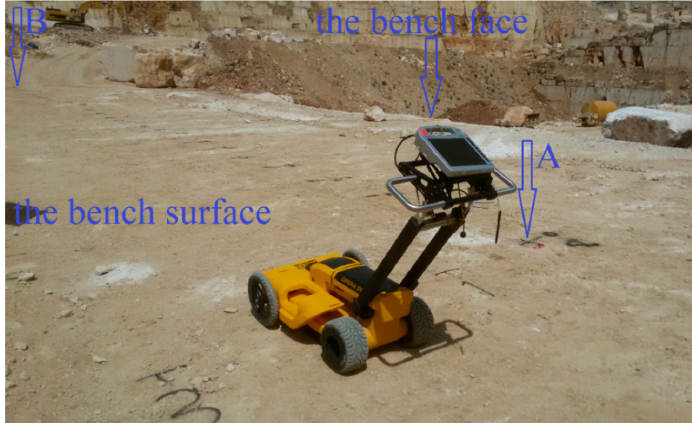
Figure 5. The GPR unit used, and the indications of points A and B on the bench surface.